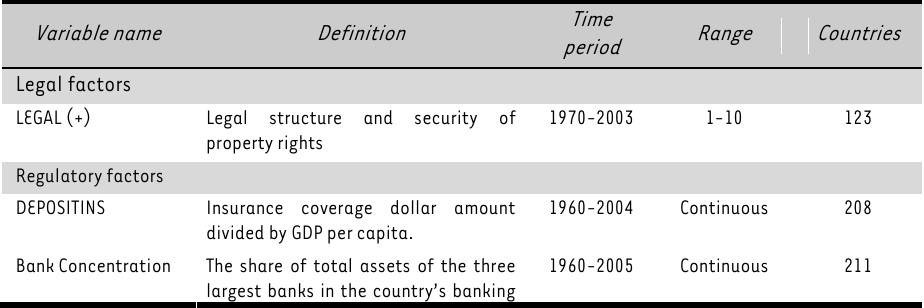
List of external factors: legal, regulatory, and technological (expected signs